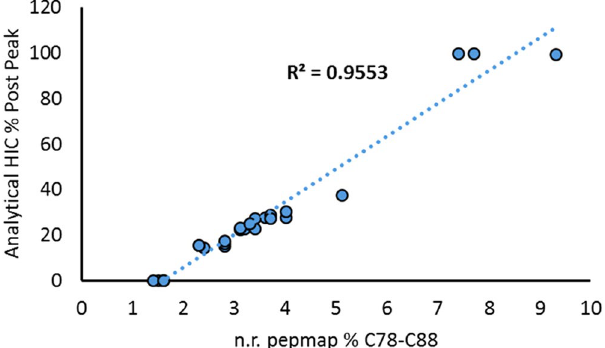
Figure 3. Approximation of overall incorrect disulfide bridging using analytical hydrophobic interaction chromatography. Samples with different potencies, such as GP2015 (Erelzi ® ) drug substance, process intermediates and late eluting HIC fractions were analyzed using the analytical HIC and the non reducing peptide map methods. The abundance of incorrect disulfide bridging assessed by these methods was found to correlate, allowing approximation of how the relative amount of C 78 -C 88 assessed by the non reducing peptide map corresponds with overall incorrect disulfide bridging in etanercept, as reflected by the HIC post peak.